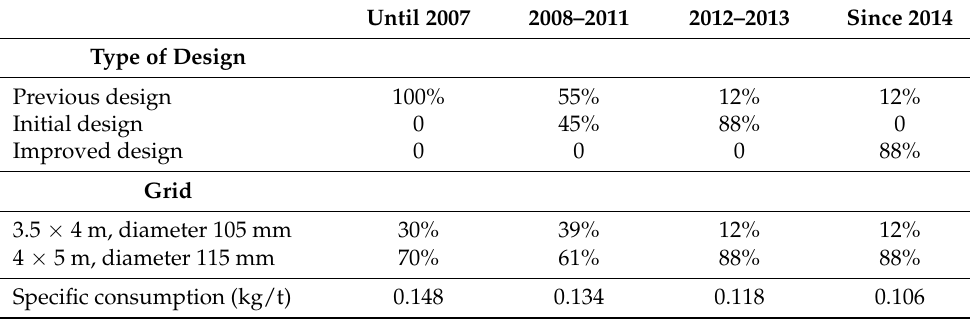
Table 8. Type of blast design and grid used over time.